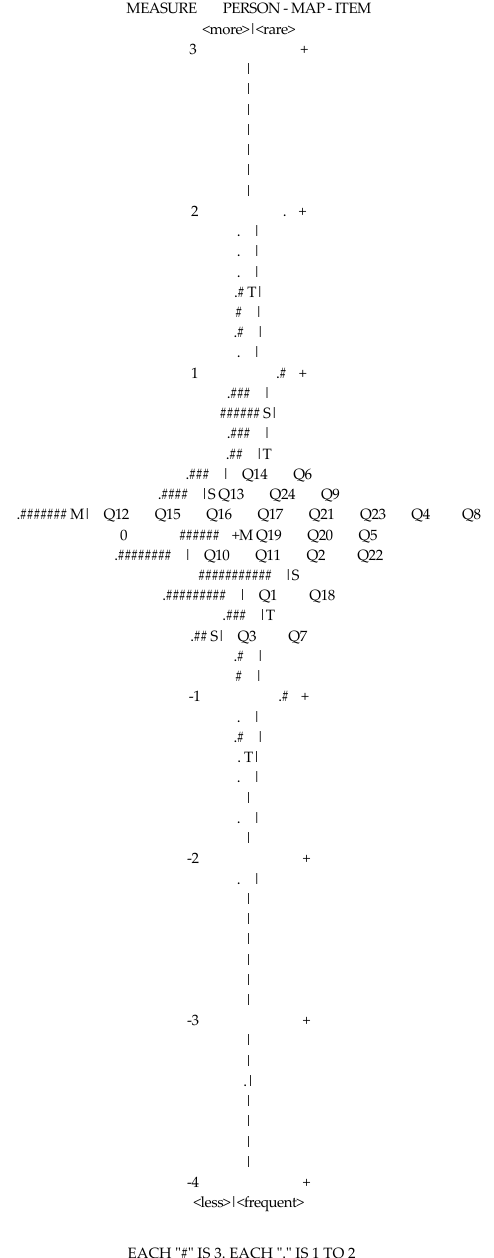
Figure 1. Item goodness-of-fit of the electric protector cognition scale.